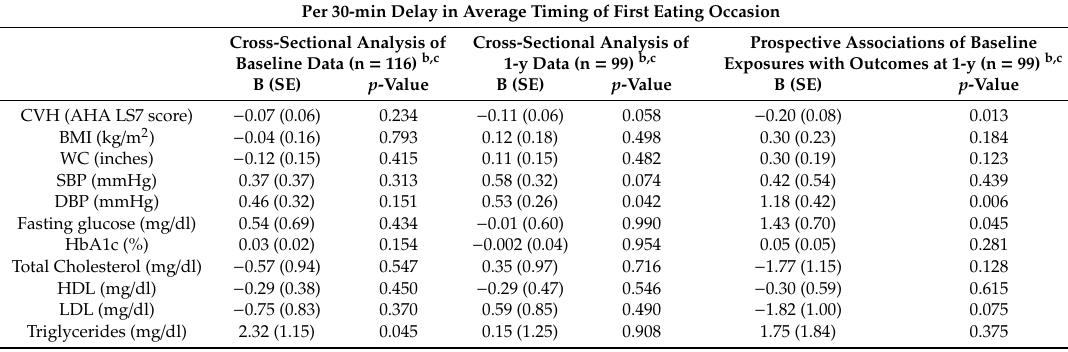
Table 3. Linear Regression Models for Cross-sectional and Prospective Associations of Average Timing of First Eating Occasion with Cardiovascular Health and Cardiometabolic Risk Factors a